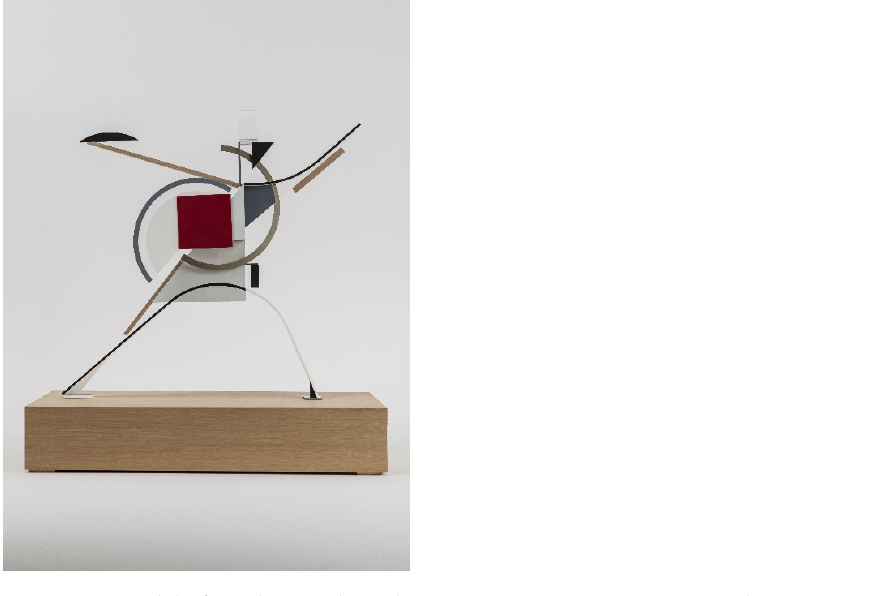
Figure 23. Model after El Lissitzky, ‘The New Man’, 1923, construction by Henry Milner, 2009. Van Abbemuseum. Photo: Perry van Duijnhoven.